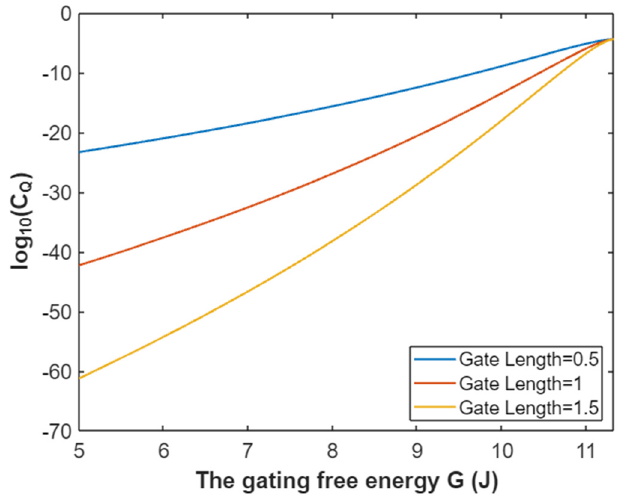
Figure 27. The relationship between gating free energy and the common logarithm of quantum conductance of a single potassium channel for extracellular potassium ions at membrane potential of 0.087 V and over a gating free energy range from 5 J to 11.33